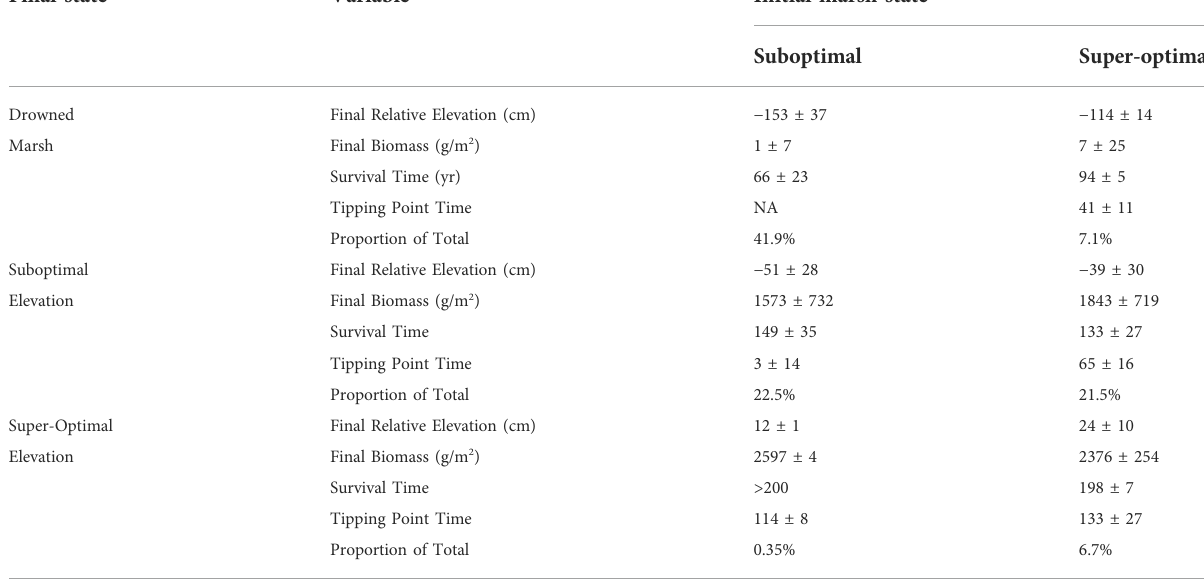
TABLE 2 Conditional probabilities of centenary regime change computed from permutations of starting relative elevation from -98 to 68 cm in 5 cm increments and centenary sea-level rise of 40 – 200 cm in 10 cm increments. Outcomes were organized into three groups (drowned marsh,